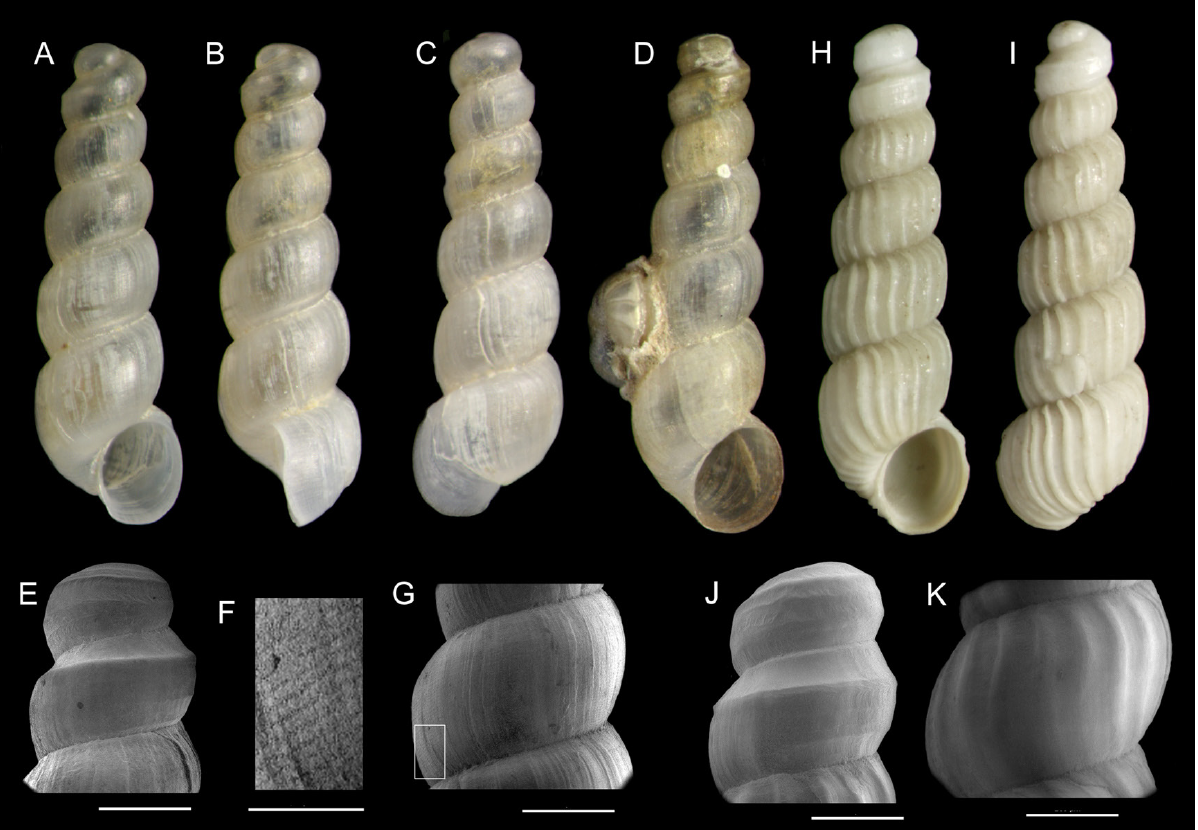
Fig. 7. – Graphis spp. from haul BT04. A-C: Holotype of Graphis pruinosa Gofas and Rueda, n. sp. (height 2.1 mm). D: paratype, live col- lected (height 2.2 mm); note the foraminifer Cibicidoides sp. attached. E. ESEM micrograph of the protoconch of another paratype (shell). F-G: ESEM micrographs, detail of the penultimate whorl of the holotype; the highly magnified area in F corresponds to the rectangle on G. H-I: Shell of Graphis gracilis Monterosato, 1874 (height 2.3 mm). J: ESEM micrograph of the protoconch of another shell of Graphis gracilis . K: ESEM micrograph of the penultimate whorl, same shell as J. Scale bars for E, G, J, K: 200 µm, for F: 50